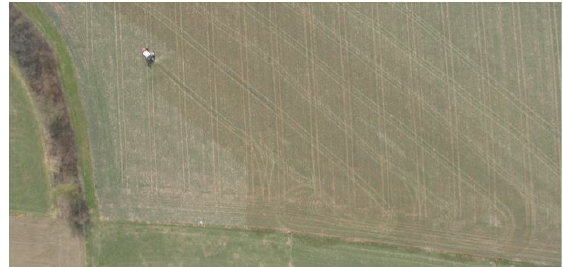
Figure 7: Simple aerial photo as a place holder for any down looking imaging in one of the under wing pods. In this case, actual land use was documented – fertilizing the field using a slurry